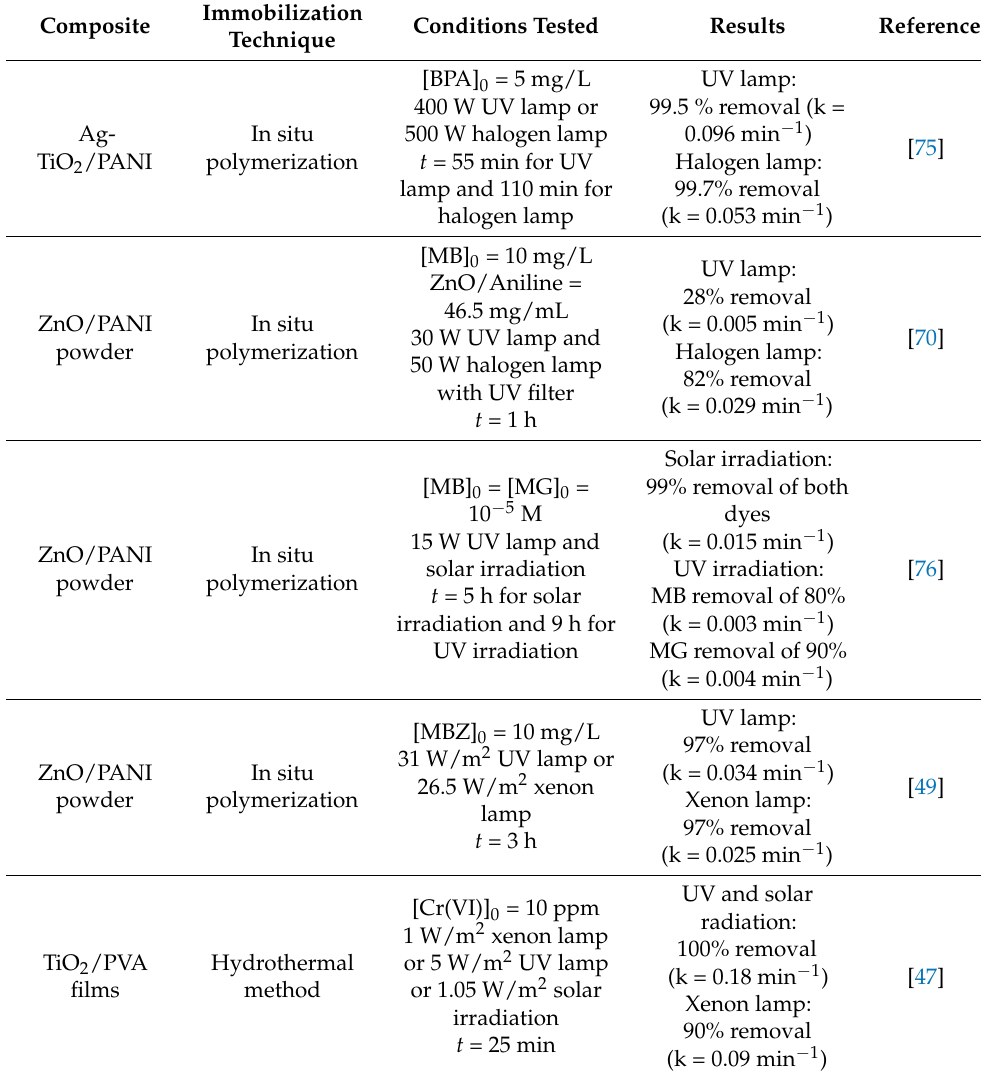
Table 7. Summary of studies that have analyzed the effect of the radiation source on the polymer- supported photocatalysis